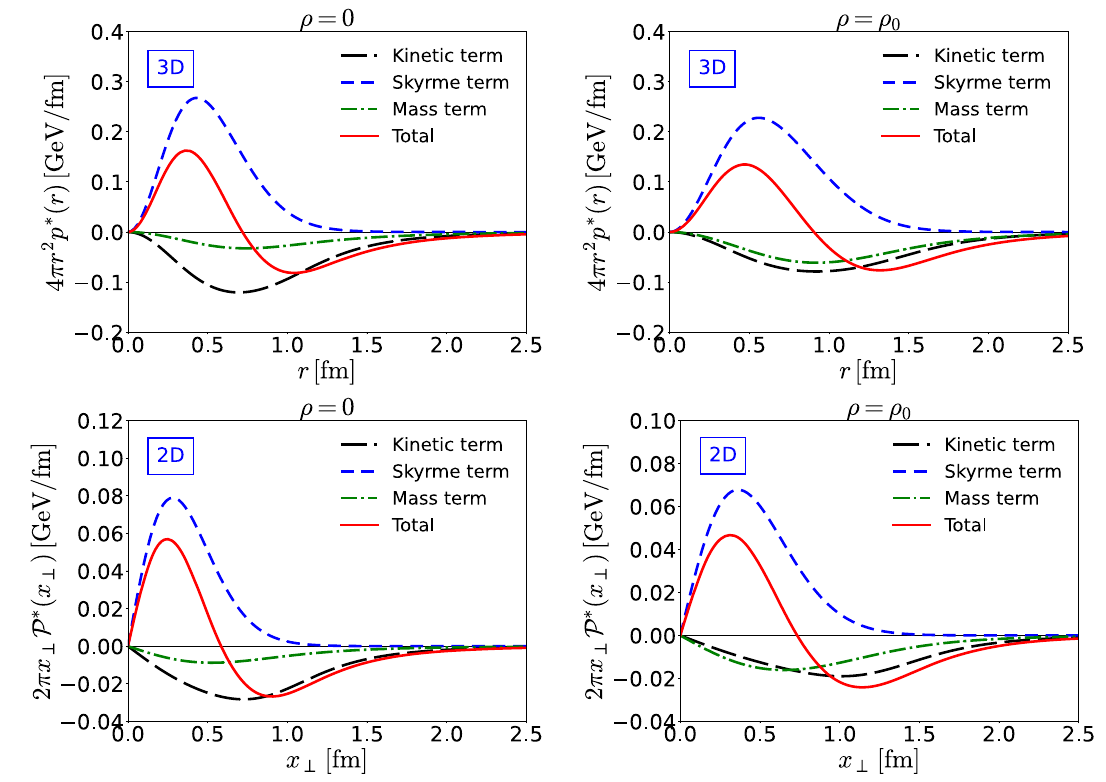
Fig. 4 3D and 2D pressure distributions of the nucleon. The upper-left (right) panel depicts the 3D pressure distributions multiplied by 4 π r 2 at ρ = 0 ( ρ = ρ 0 ). The lower-left (-right) panel draws the 2D pressure distributions with 2